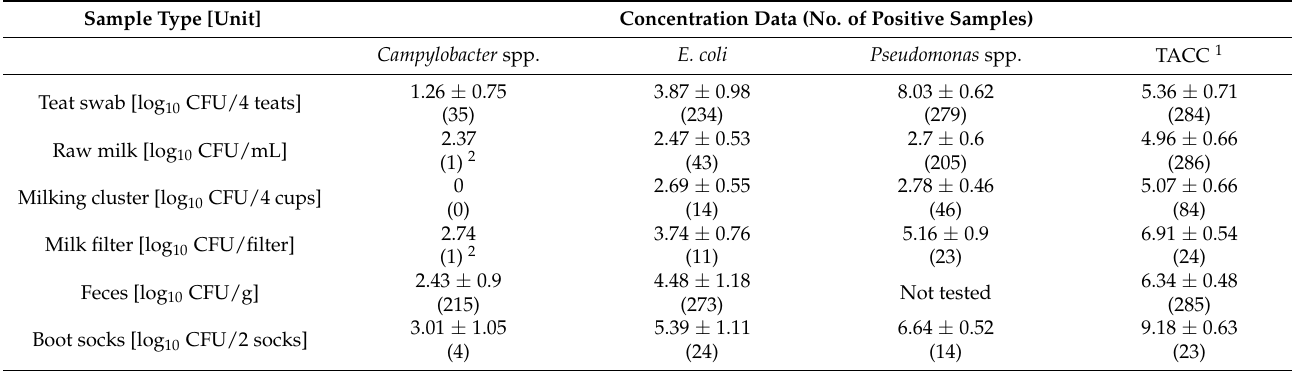
Table 2. Mean log 10 concentration and standard deviation for all sample types and microorganisms analyzed.